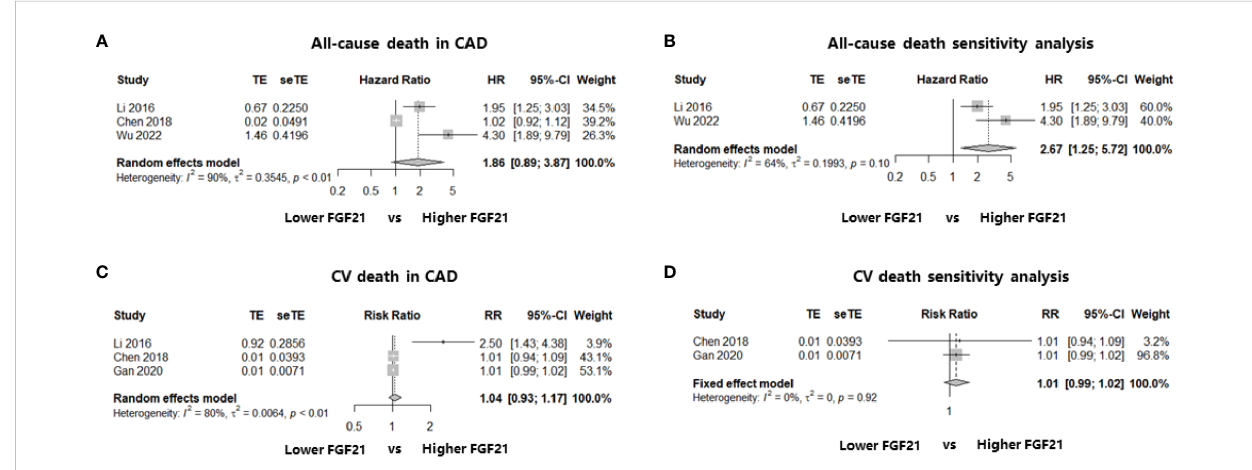
FIGURE 3 Forest plots of the association of FGF21 with all-cause death or CV death in patients with CAD. Figure 3 shows the synthesized effect sizes of FGF21 on predicting all-cause death or CV death among CAD patients. (A) FGF21 and all-cause death in CAD; (B) sensitivity analysis of all-cause death in CAD; (C) FGF21 and CV death in CAD; (D) sensitivity analysis of CV death in CAD. FGF21, fi broblast growth factor 21; CV death, cardiovascular death.